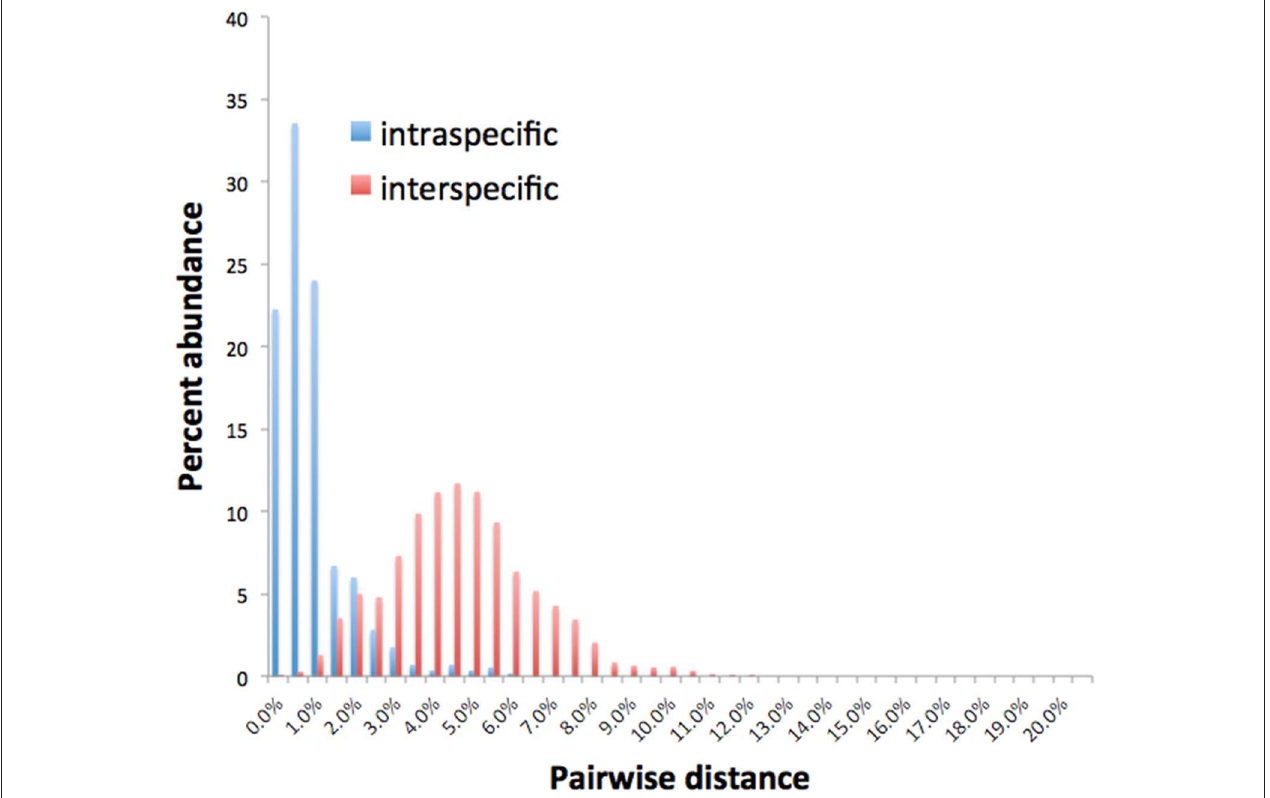
FIGURE 3 | Frequency of uncorrected “ p ” intra- and interspecific CAD distances.